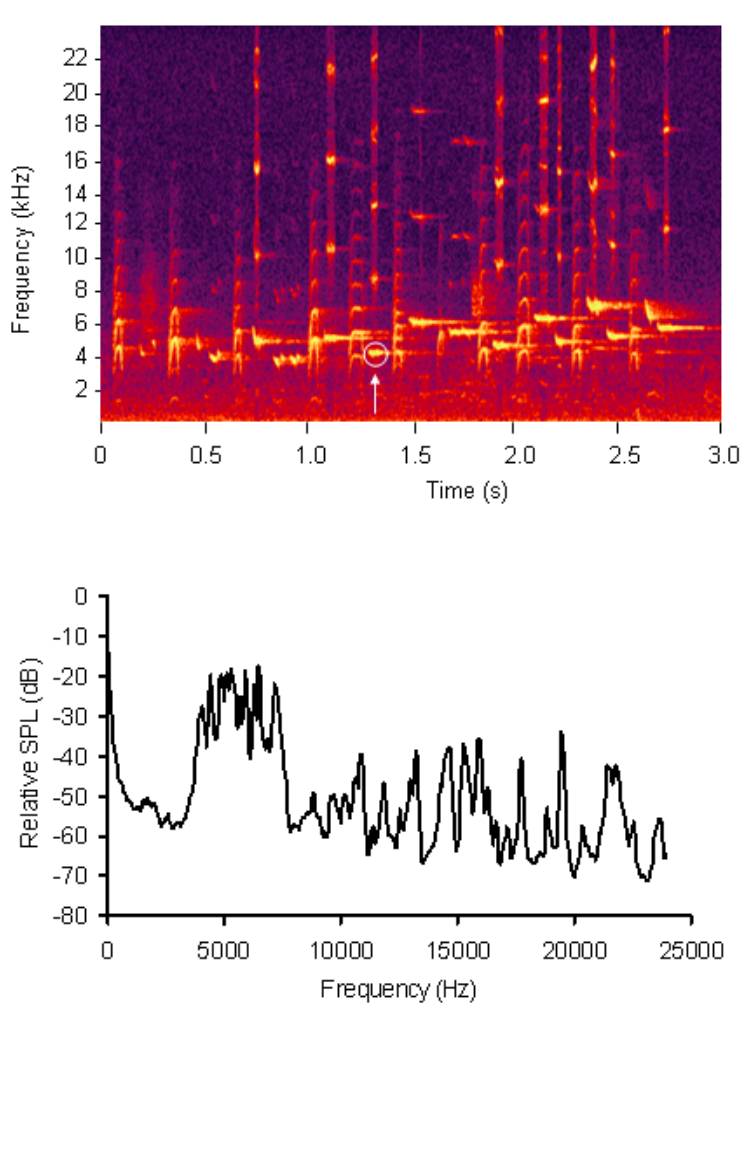
Fig. 2. Sonogram and power spectrum of a song of the Grey Fantail ( Rhipidura fuliginosa ), produced using Adobe Audition 2.0. The lowest tonal note is indicated with a circle and an